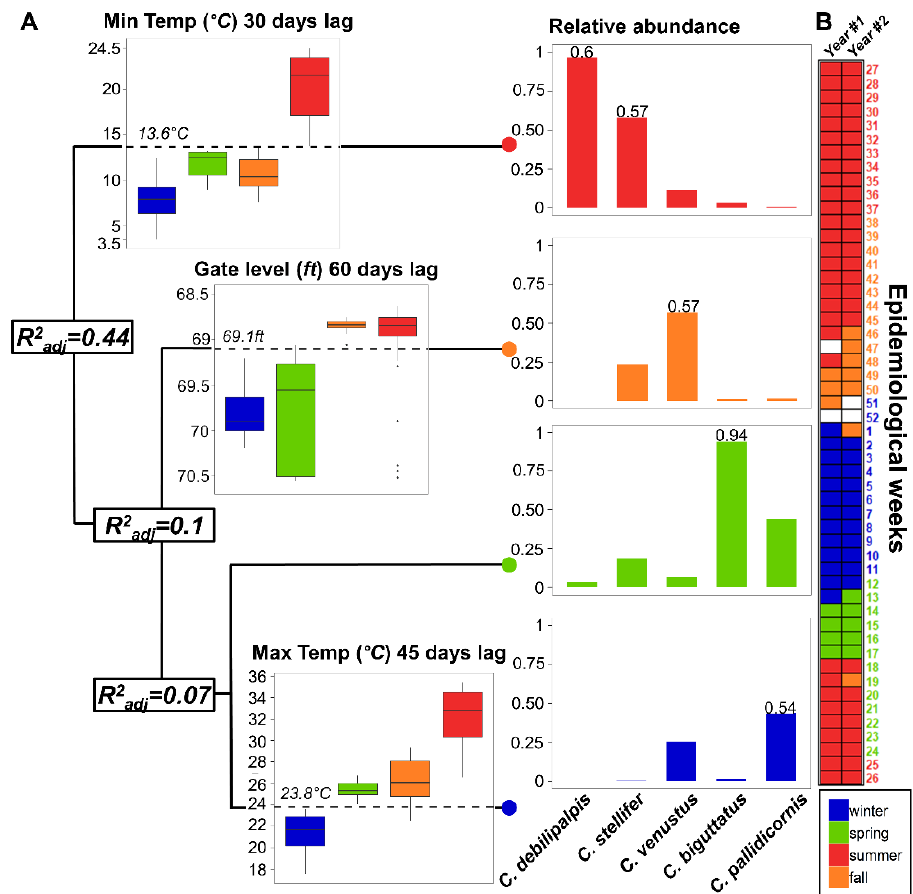
Figure 7. Culicoides vector subassemblage is time-partitioned through a hierarchy of environmental thresholds. ( A ) The regression tree displays the clustering process for the dissimilarity of vector subassemblage among sampling weeks achieved through a sequence of environmental thresholds. Branch splitting gives place to nodes (colored dots; cluster of epidemiological weeks) and a new branch in a way to predict the amount of variation explained at each step (R 2adj ). Distribution of environmental variables at the clusters level are plotted in a box-chart, and threshold value is printed. Moreover, vector relative abundance distribution is presented in bar-charts, and significant indicator species value is labeled. ( B ) Matching between clusters and calendar is represented by a time-line matrix (Year #1: July 2015–June 2016; Year #2: July 2016–June 2017). Cells are filled as a cluster and week labels colored as calendar season. Empty cells represent weeks without sampling.